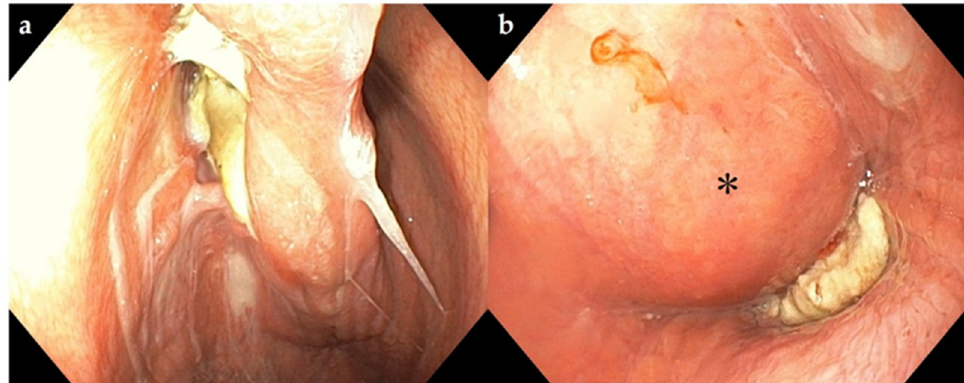
Figure 3. Endoscopic view of the dorsal aspect of the nasal passage and the upper respiratory tract with a retropharyngeal mass. ( a ) Pus-like material adherent to the dorsum of the nasal passage; ( b ) mass (*) in the pharyngeal region obstructing the airways.